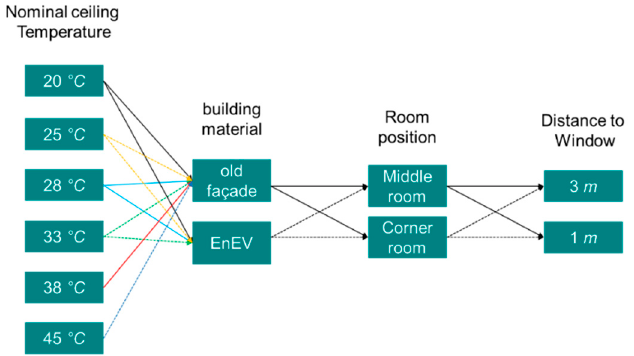
Figure 4. Presentation of combinations of scenarios for the CFD–thermoregulation simulations.